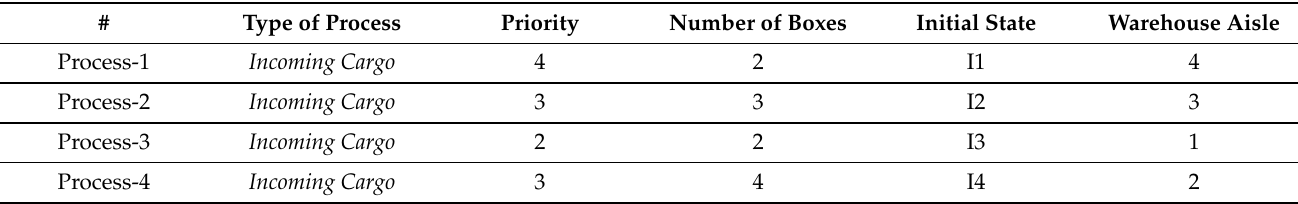
Table 2. Description of Experiment 2: